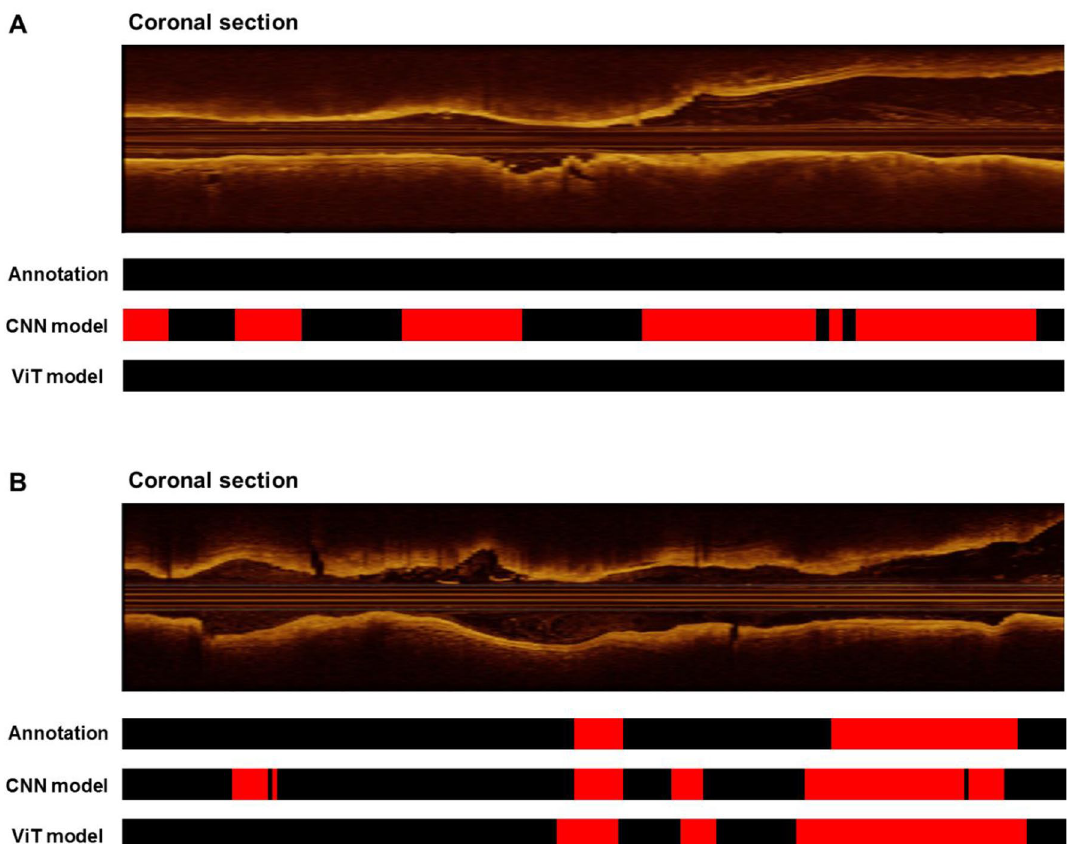
Figure 4. Visualization of the model predictions in sequence-level. As shown in the representative cases, the vision transformer (ViT)-based model showed higher agreement with the ground truth annotation than the convolutional neural network (CNN)-based model, both in ( A ) the negative case and ( B ) the positive case for layered